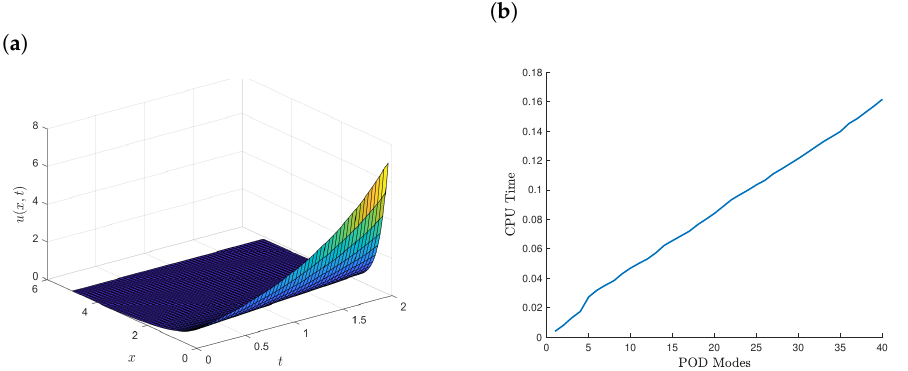
Figure 3. ( a ) Surface plot of the EUPFD solution of the linear ADR equation. ( b ) Number of POD modes vs. CPU time for the linear reaction diffusion equation. Figure 4a,b show the absolute errors between the exact solution and EUPFD solution for the linear ADR against time and space,